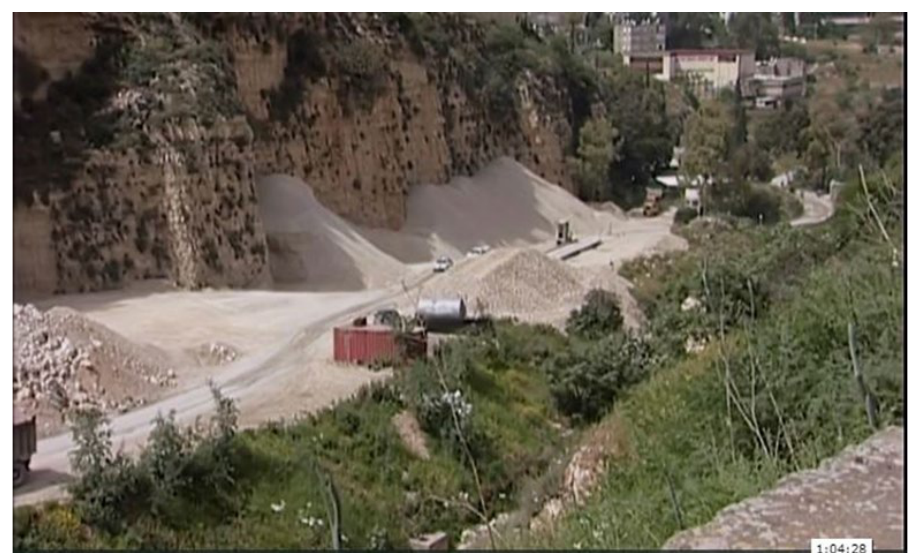
Figure 7 works in the Wadi, 2014, Source: 'Roshmia', Saleem Abu-Jabel,